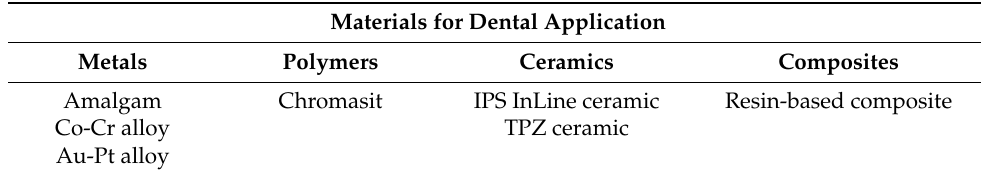
Table 1. Materials most commonly used in dental practice sorted by its composition into 4 groups. TPZ: tetragonal polycrystalline